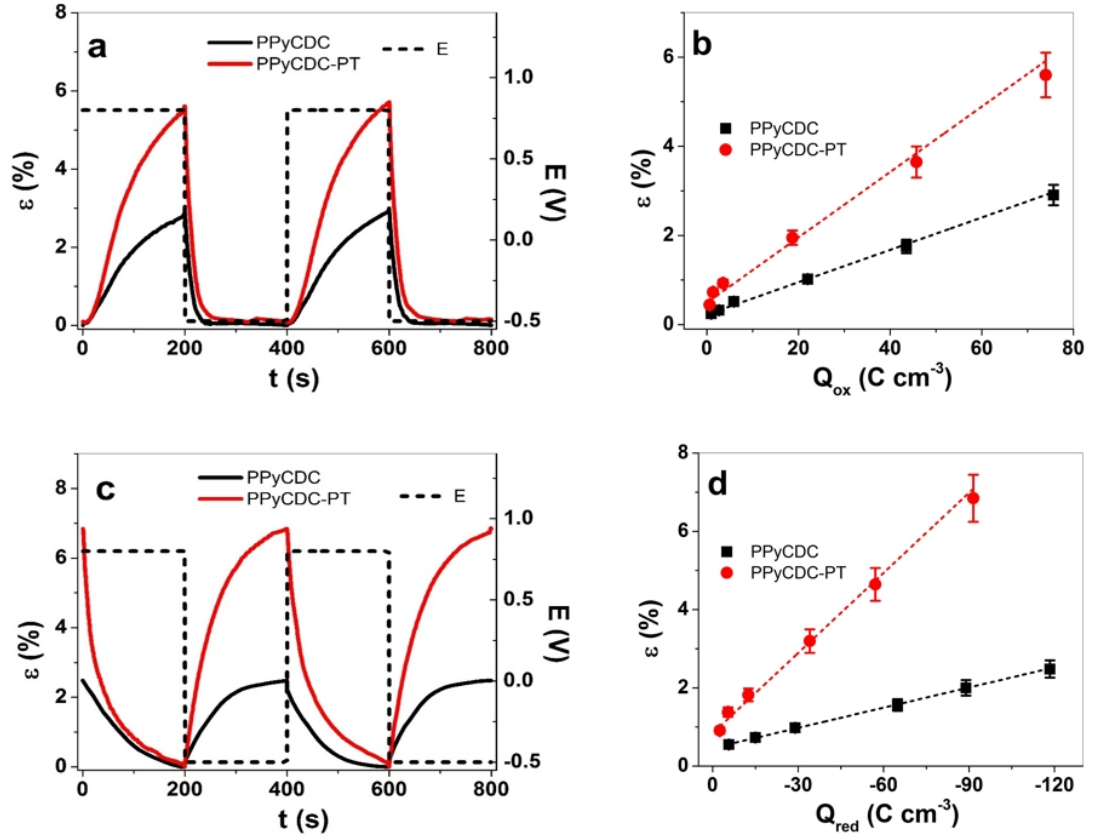
Figure 5. Square wave potential steps of PPyCDC (black line, ■ ) and PPyCDC-PT (red line, ● ) showing strain–time profile at 0.0025 Hz in the potential range E (0.8 V to − 0.5 V, black dashed line), following the 3rd to 4th cycle in ( a ) LiTFSi-PC, and ( b ) the strain against the charge densities at oxidation. In the electrolyte LiTFSI-aq, the strain–time profiles of both film samples are shown in ( c ), and the strain against charge density at reduction is presented in ( d ). The dashed line in ( b , d ) represents the linear fit and is shown for the orientation only.